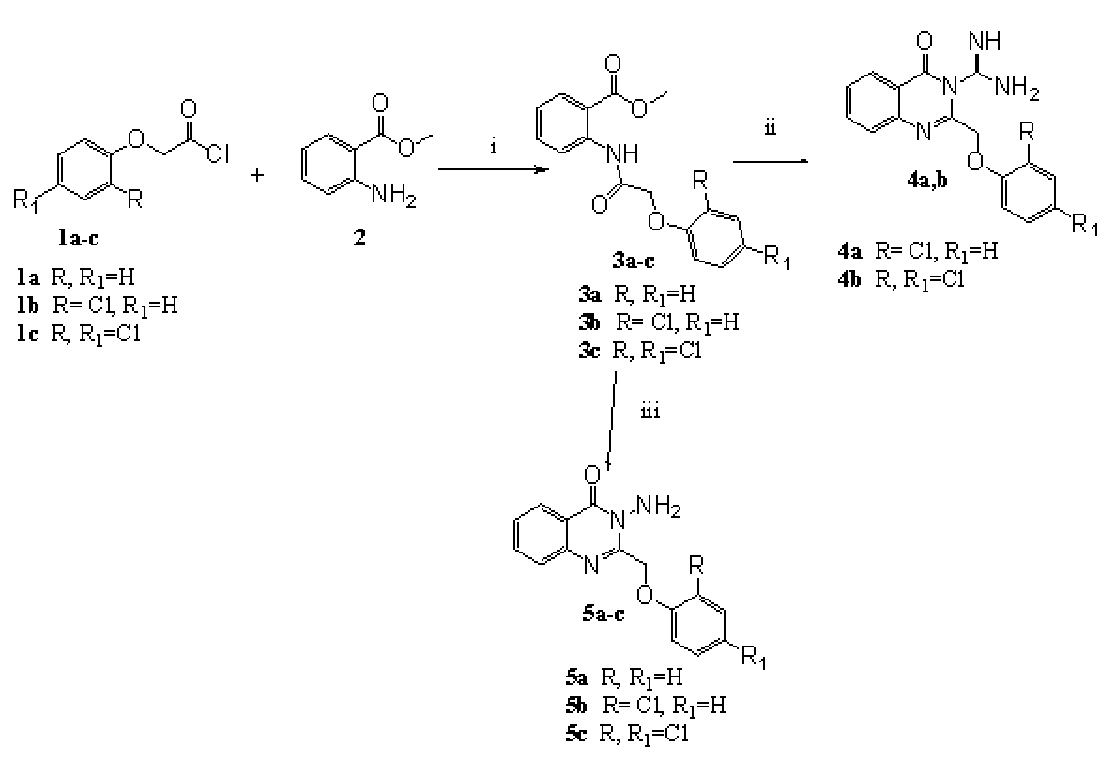
Scheme 1. Synthetic Pathway for Compounds 3-5